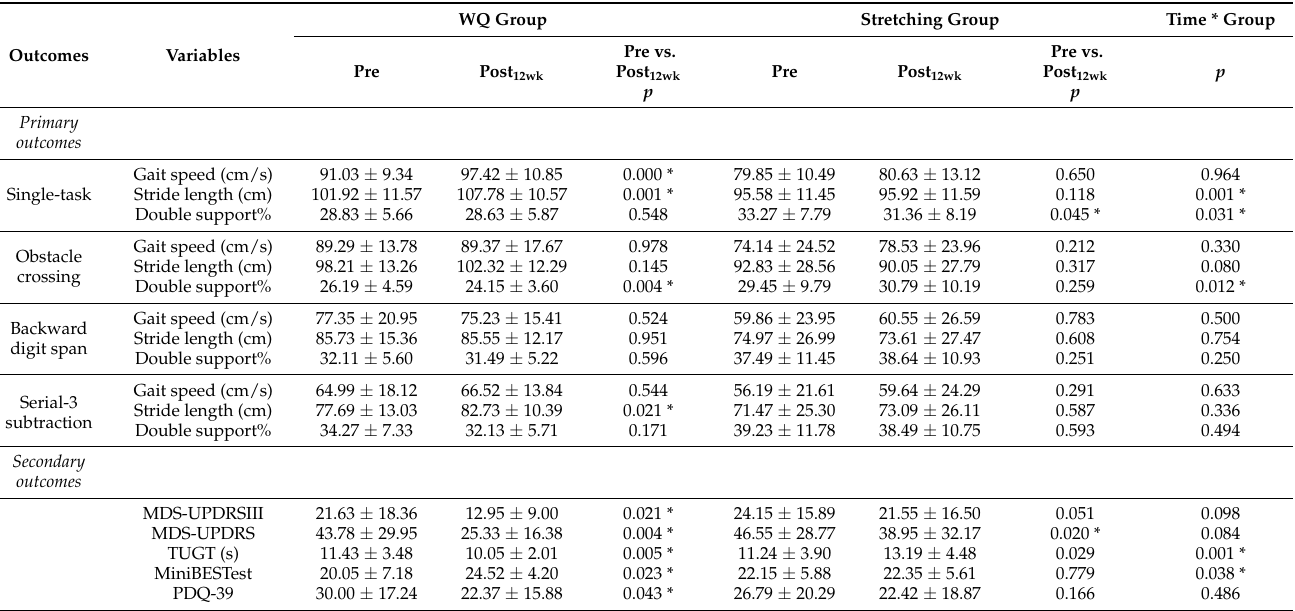
Table 2. Within-group comparisons of clinical outcomes.